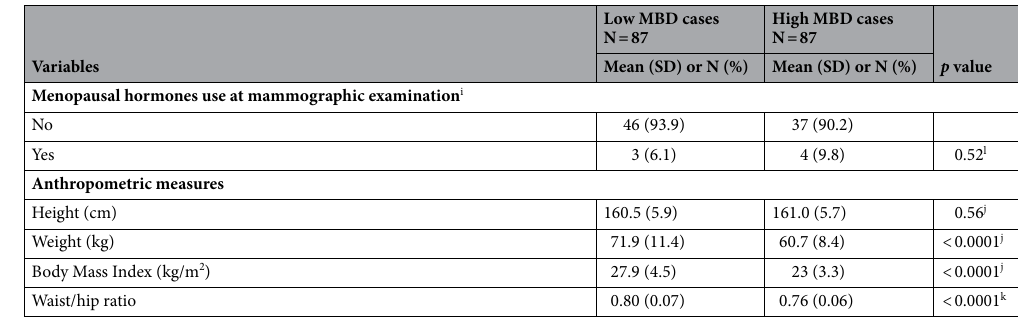
Table 1. Mean values and distribution of study participants according to the main characteristics for 87 case– case sets (EPIC Florence, low- vs high-MBD BC case–case study). a Missing = 2; b missing = 3; c missing = 23; d missing = 51; e missing = 29; f missing = 6. g No breastfeeding women or women with no full-term pregnancies. h Postmenopausal women at blood collection = 117 (missing = 16). i Postmenopausal women at mammographic examination = 152 (missing = 62). j p value from t test. k p value from Wilcoxon rank-sum test. l p value from Pearson’s